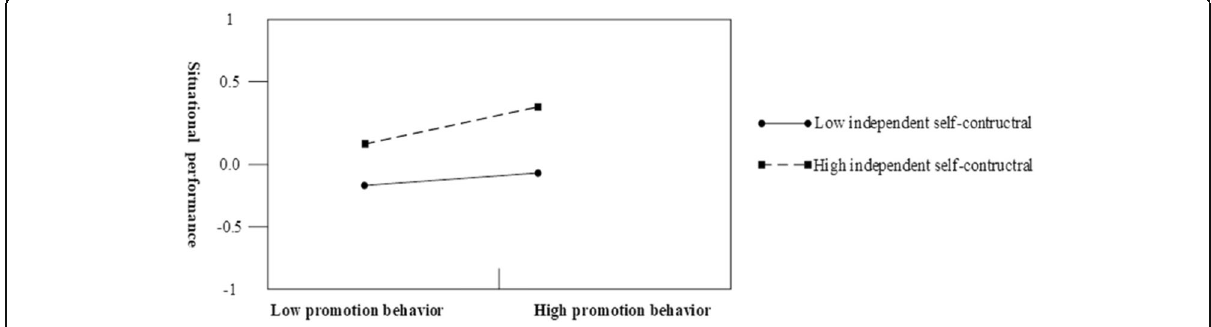
Fig. 6 Moderating effect of independent self-constructal